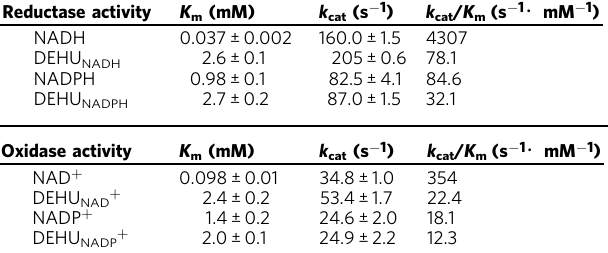
Table 1 Kinetic parameters of the reductase and oxidase activities of